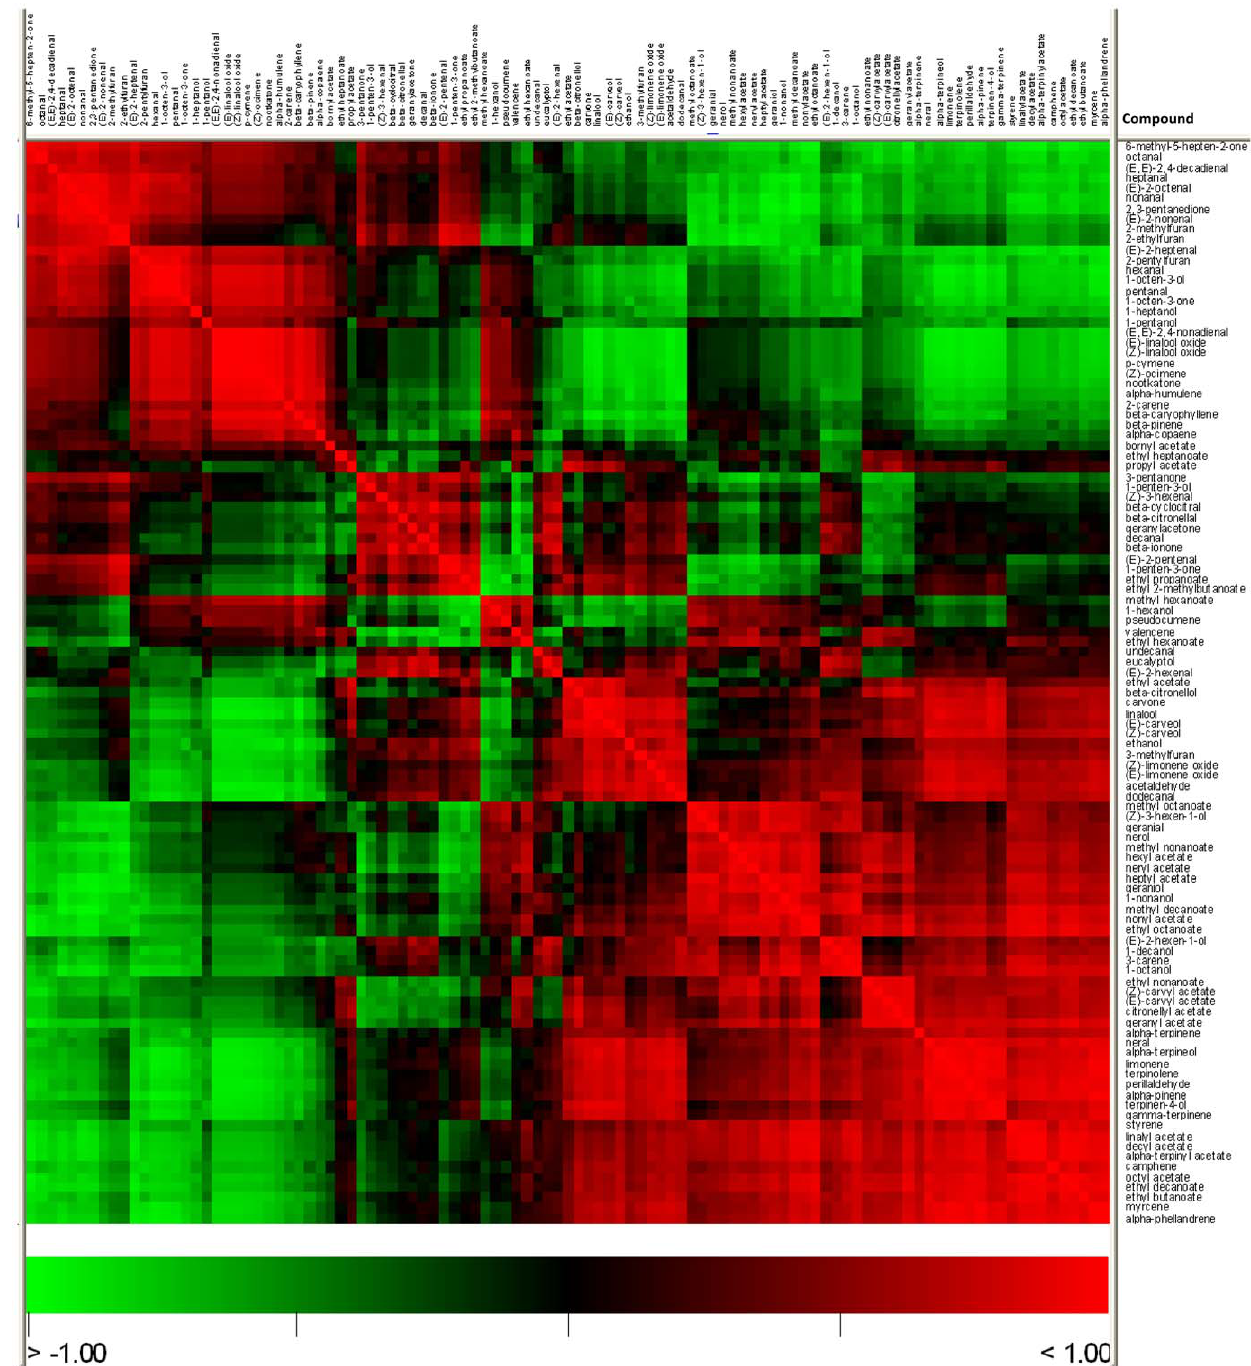
Figure 4. Heatmap of the correlation matrix of the volatile compounds. Positive correlations are shown in red; negative correlations in green; absence of correlation in black.